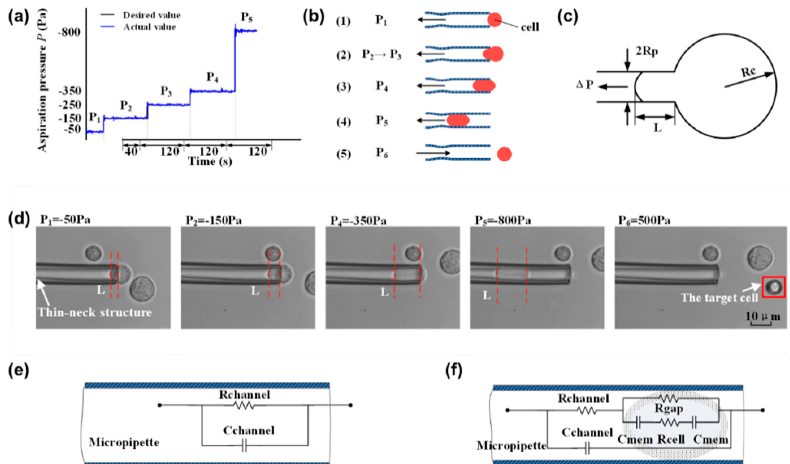
Figure 2. The aspiration procedures for quantifying physical properties of cells. ( a ) The distribution of negative pressure in the experiment for aspirating cells; ( b ) schematic diagram of the dynamic process of the micropipette attracting an individual cell; ( c ) homogenous half ‐ space model schematic diagram; ( d ) a micrograph of a single cell entering the thin ‐ neck ‐ micropipette; ( e ) equivalent circuit model of the micropipette when no cells are aspirated; ( f ) equivalent circuit model of micropipette when there are aspirated cells in the